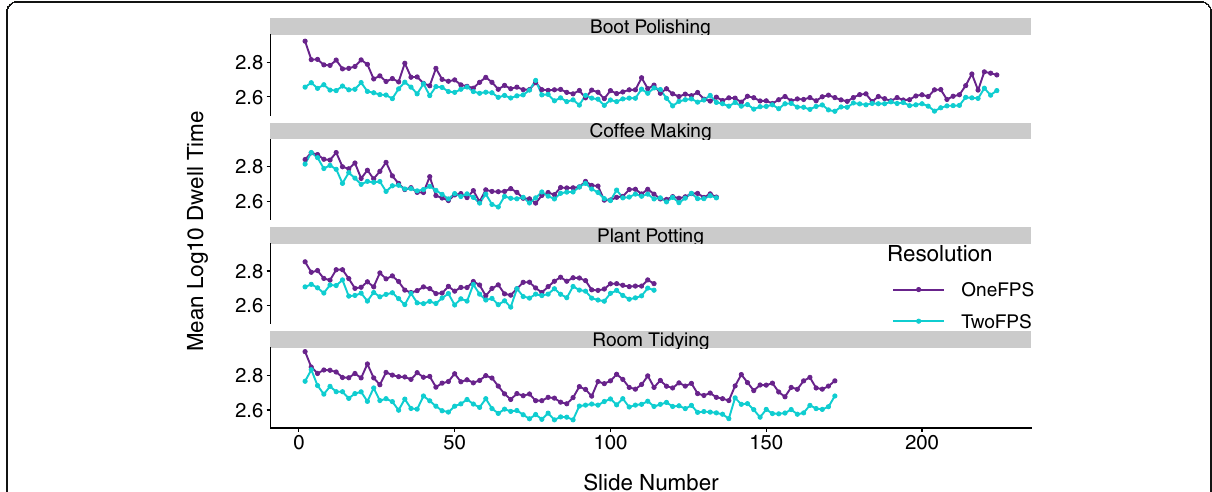
Fig. 2 Alignment of dwell-time patterns across 1-fps and 2-fps slideshow versions. Only matched slides, depicting identical content across the two levels of resolution, are included. FPS frames per